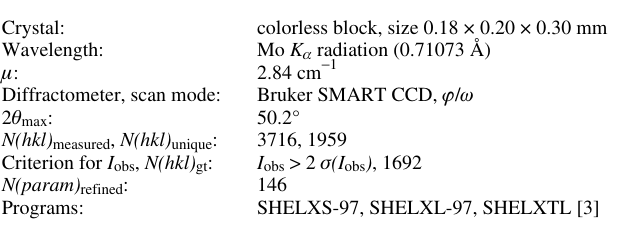
Table 1. Data collection and handling.